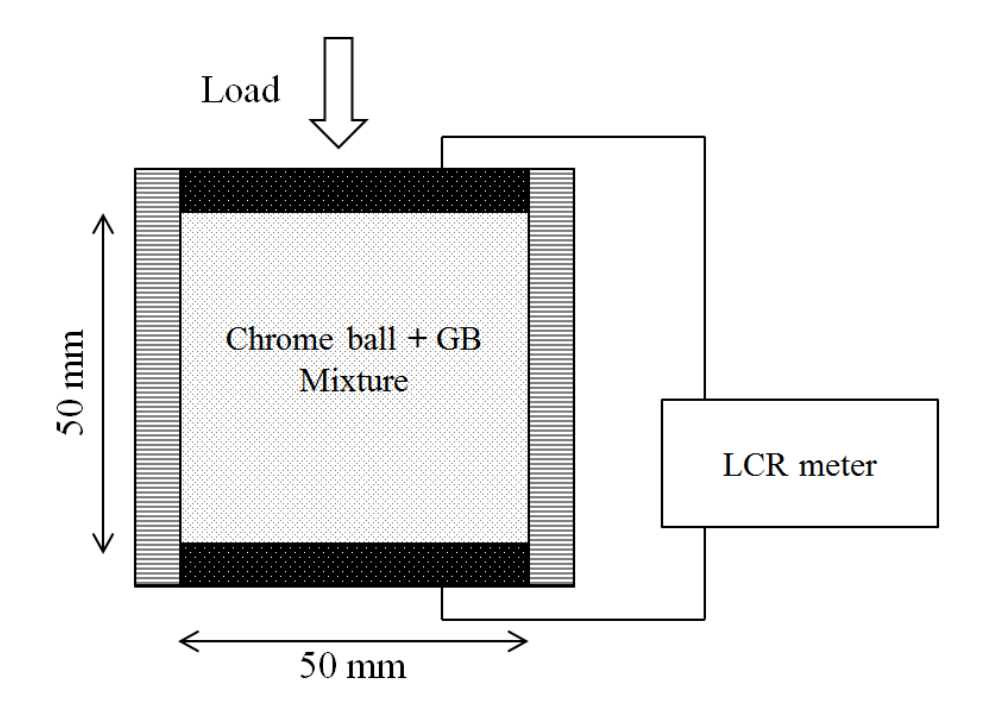
Figure 9. Experimental configuration for measuring the electrical conductivity of granular mixtures. The electrical conductance is obtained with two-point electrodes at the top and bottom plates. Table 5. Cases in chrome ball-glass bead mixture